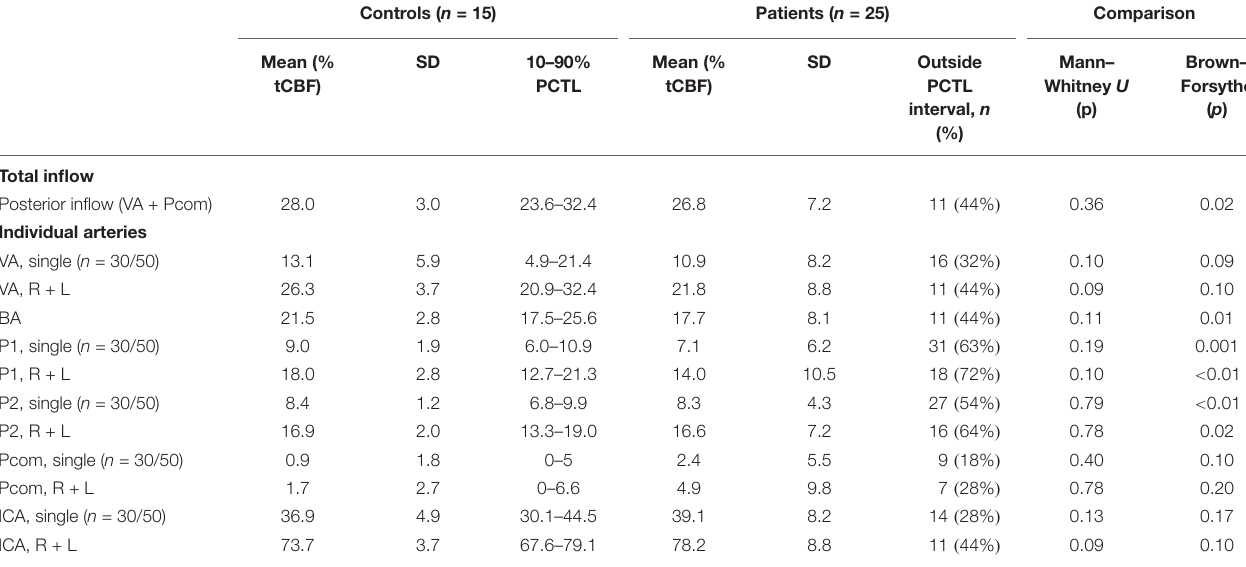
TABLE 2 | Proportion of total CBF (in %) for the main arteries of the posterior circulation in patients ( n = 25) and controls ( n = 15). Controls ( n =